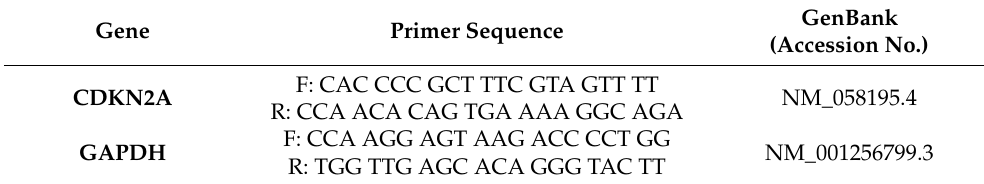
Table 2. Primer’s sequence used for qRT-PCR of normal and cancer skin cell lines.